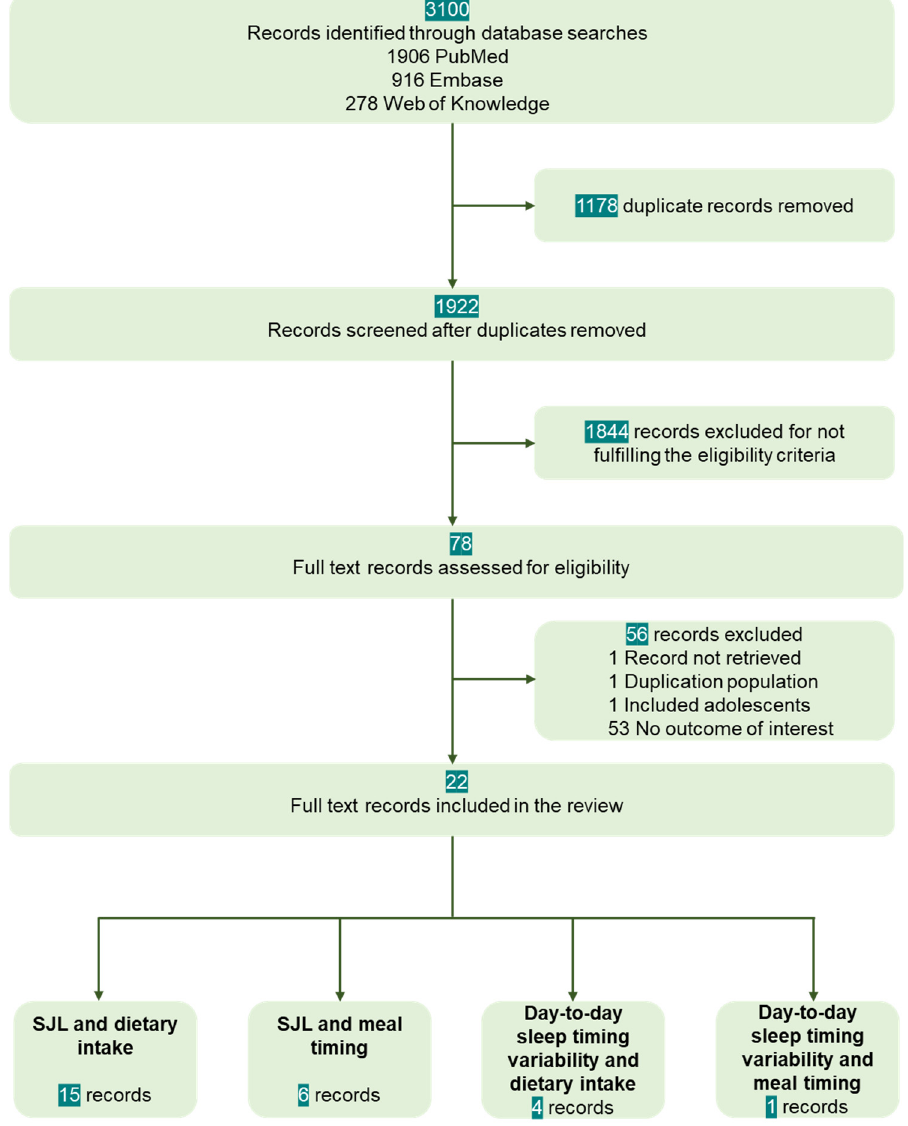
Figure 1. Records selection process.